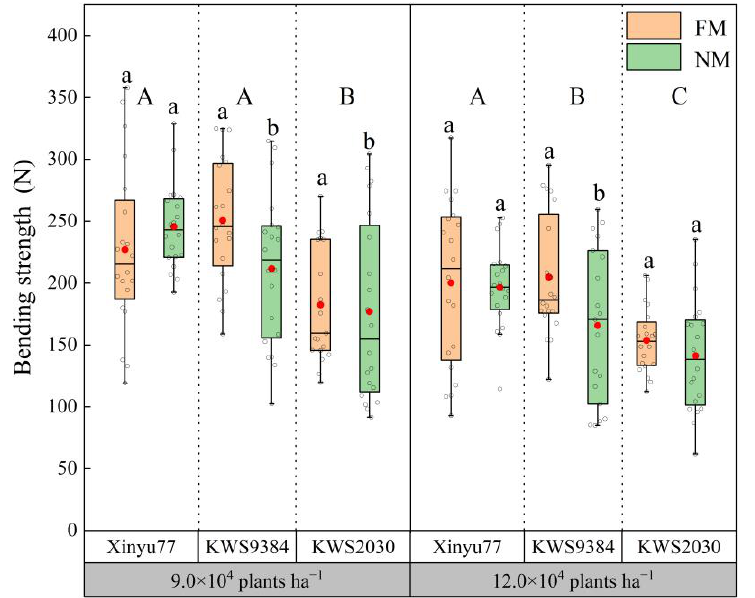
Figure 4. Differences in the basal internode bending strengths between film mulch (FM) and no-film (NM) planting under different planting densities and cultivars. The boxes represent IQRs, the whiskers indicate reasonable sample borders (Tukey tests), the horizontal line in each box indicates the median, and the solid red dot shows the mean. Different lowercase letters indicate significant differences ( p < 0.05) between the FM and NM treatments. Different capital letters indicate significant differences ( p < 0.05) among cultivars.